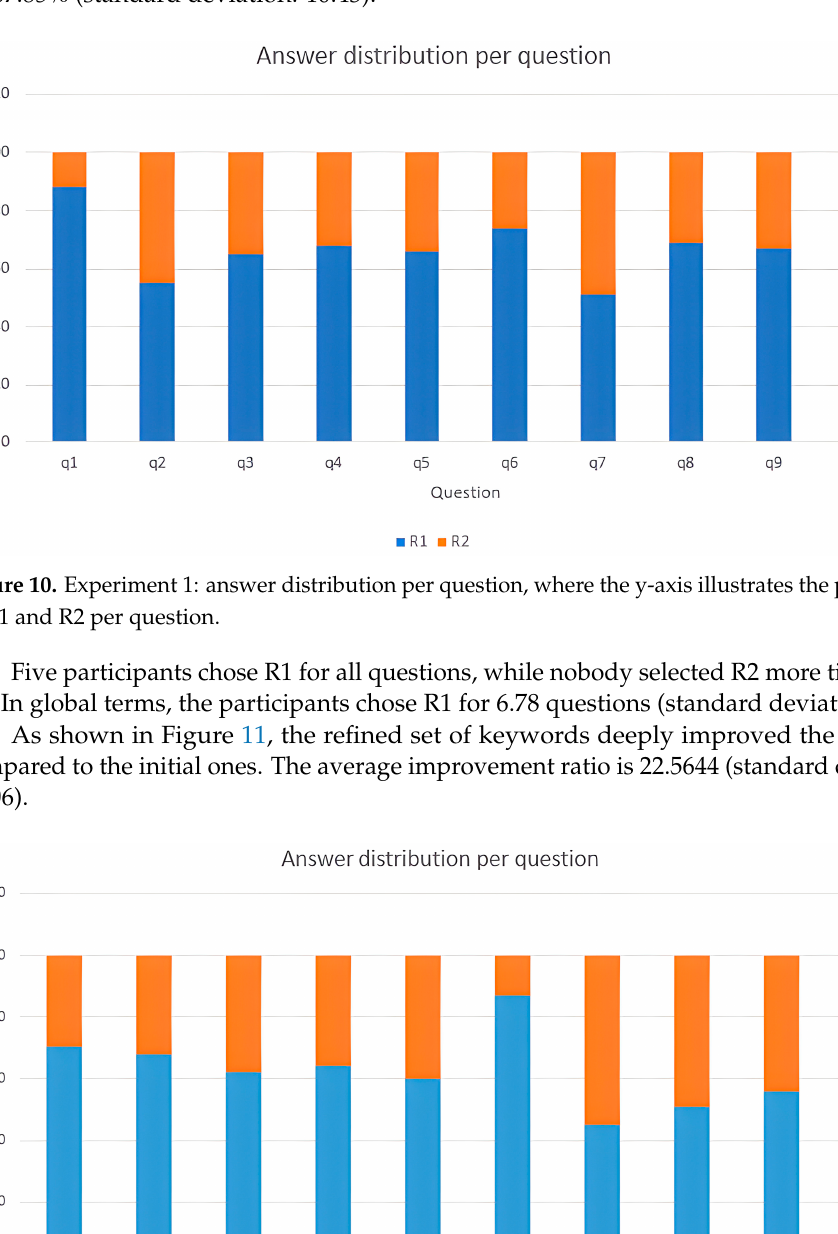
Figure 11. Experiment 2: answer distribution per question, where the y-axis illustrates the percent- age of R1 and R2 per question.